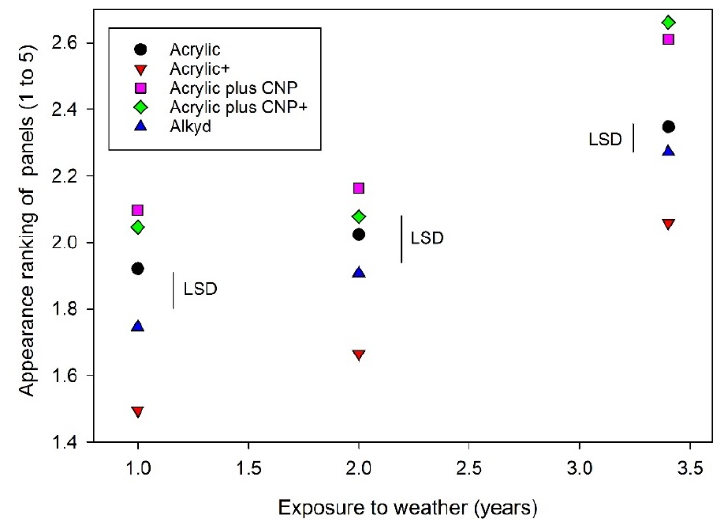
Figure 4. Effect of coating type on the appearance ranking of modified and treated yellow cedar wood panels exposed to the weather. Results are averaged across panels treated with different chemicals. Bars associated with data points represent the least significant difference (LSD, p < 0.05).